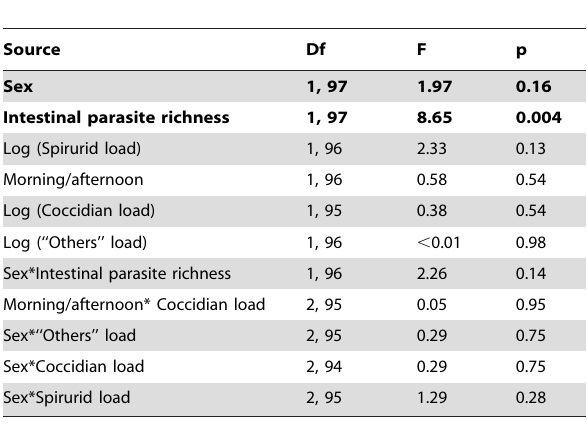
Table 2. Relationships between migration time and blood parasite prevalence and